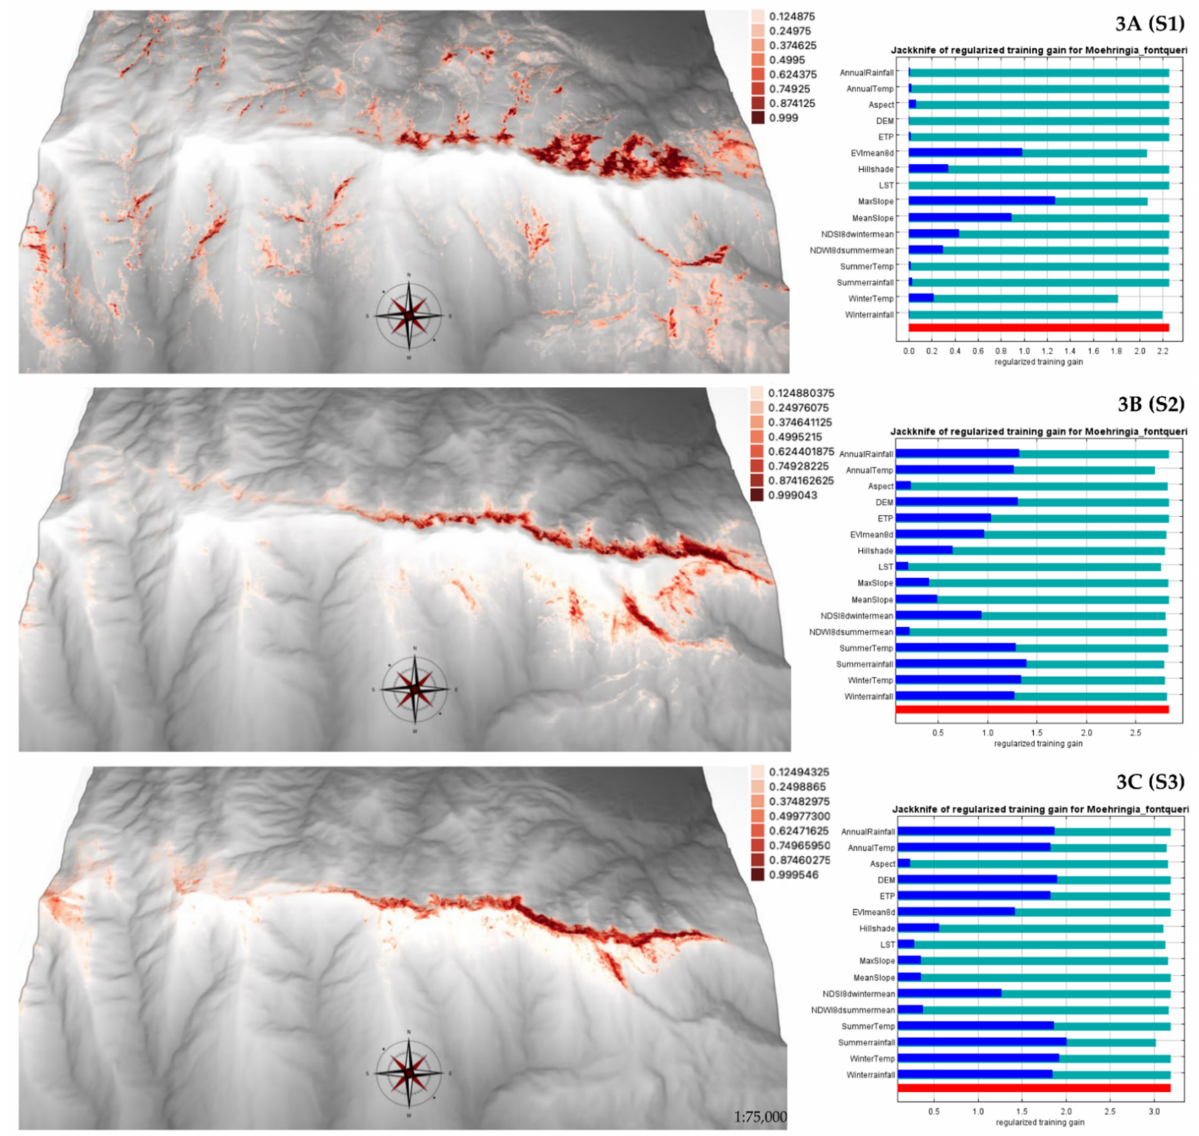
Figure 3. Models of current potential distribution of Moehringia fontqueri derived from occurrences segregated by elevational ranges 3A (S1) , 3B (S2) , 3C (S3) . Regularized training gain values of the jackknife